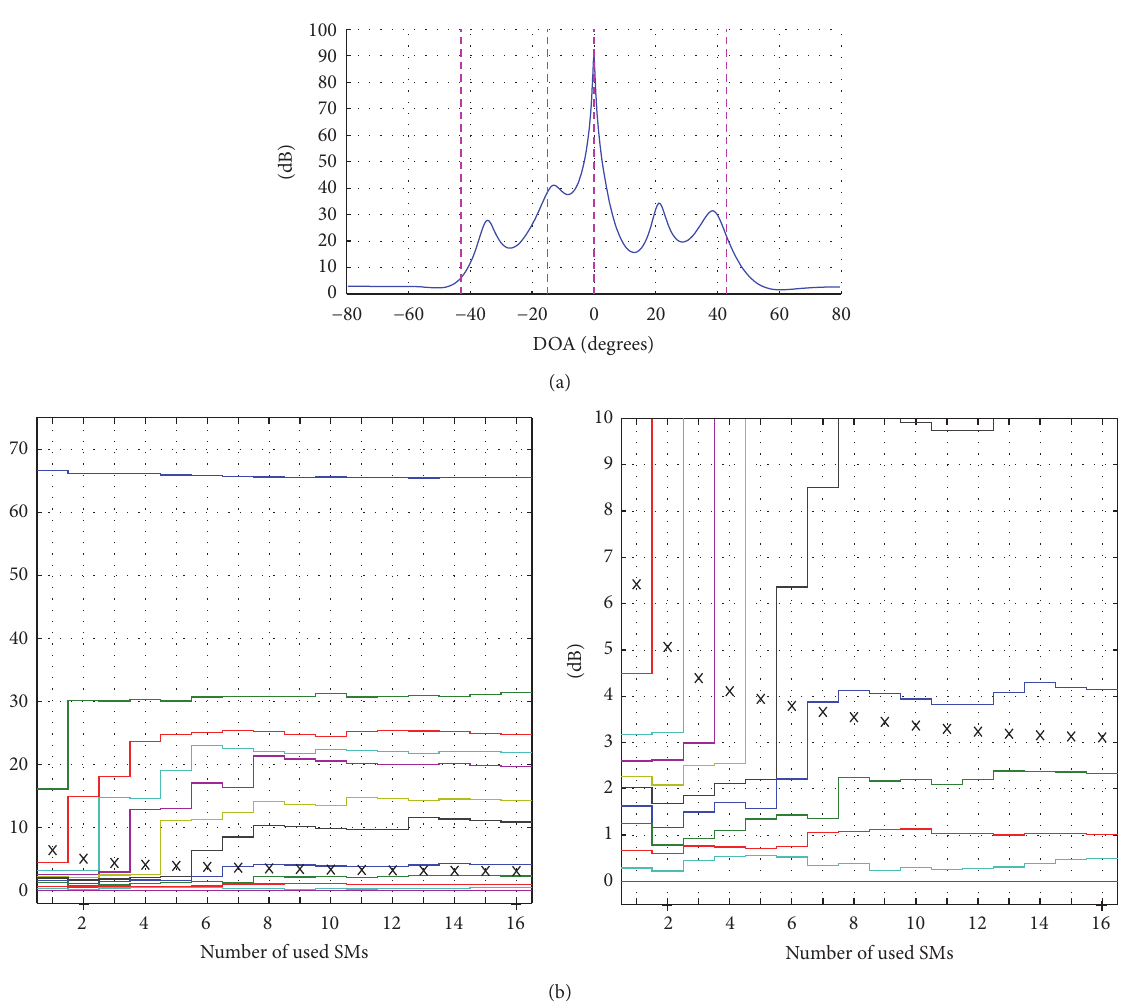
Figure 14: Measurement U2SW. Two uncorrelated transmitters, one strong and one weak. (a) Capon DOA spectrum. (b) Eigenspectrum. Zoom-in to the right. dB scale. See Section 3.3 for